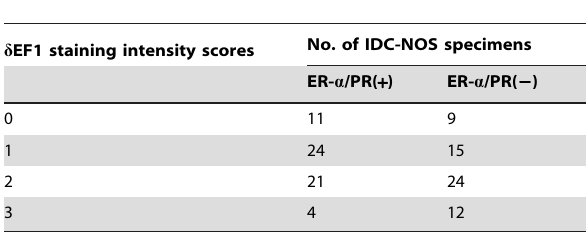
Table 1. Inverse correlation between d EF1 and ER- a expression in breast